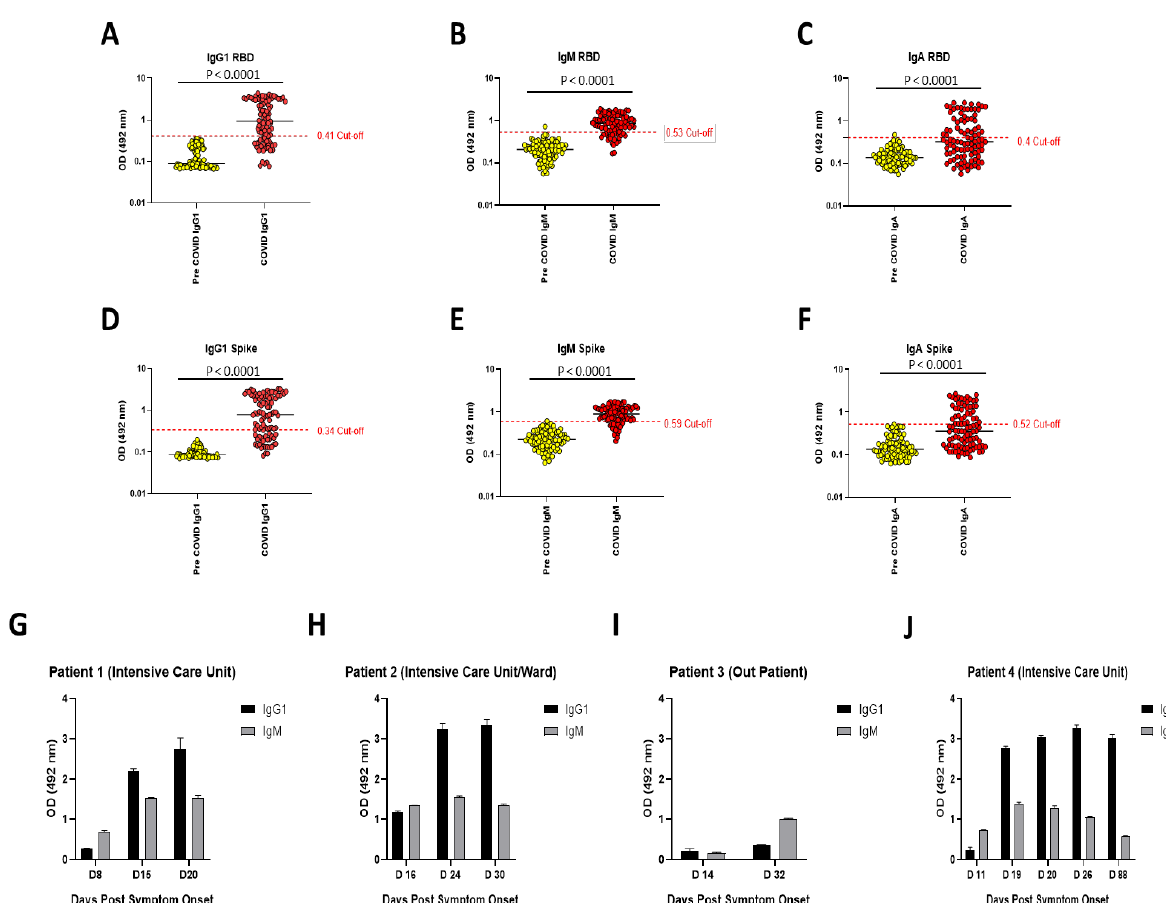
Figure 2. OD values representative of antibody reactivity in sera from pre-COVID-19 and confirmed SARS-CoV-2 patients. ( A – C ) Results of samples tested against RBD. ( D – F ) Results of samples tested against full-length spike protein. Statistical analysis was performed using Mann–Whitney U tests in GraphPad Prism. The samples represented here were taken >7 days post symptom onset and include 103 pre-COVID-19 and 91 SARS-CoV-2 positive samples. Horizontal lines represent mean values and samples were performed in triplicate. ( G – J ) Examples of results from longitudinal samples.